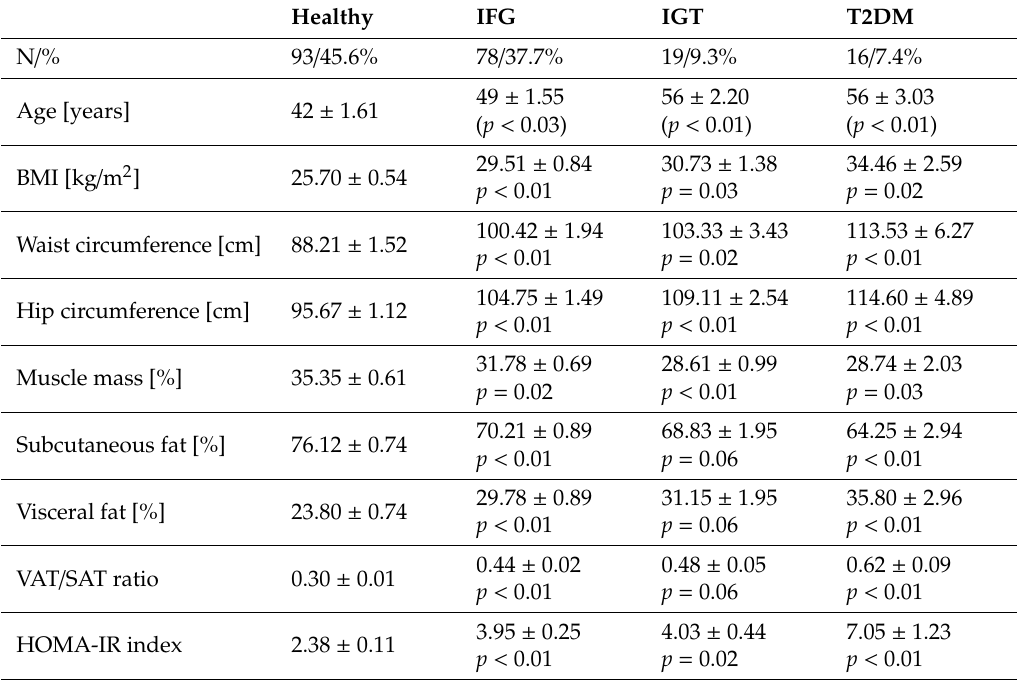
Table 2. Characteristics of subjects with prediabetes and T2DM, diagnosed at the follow-up